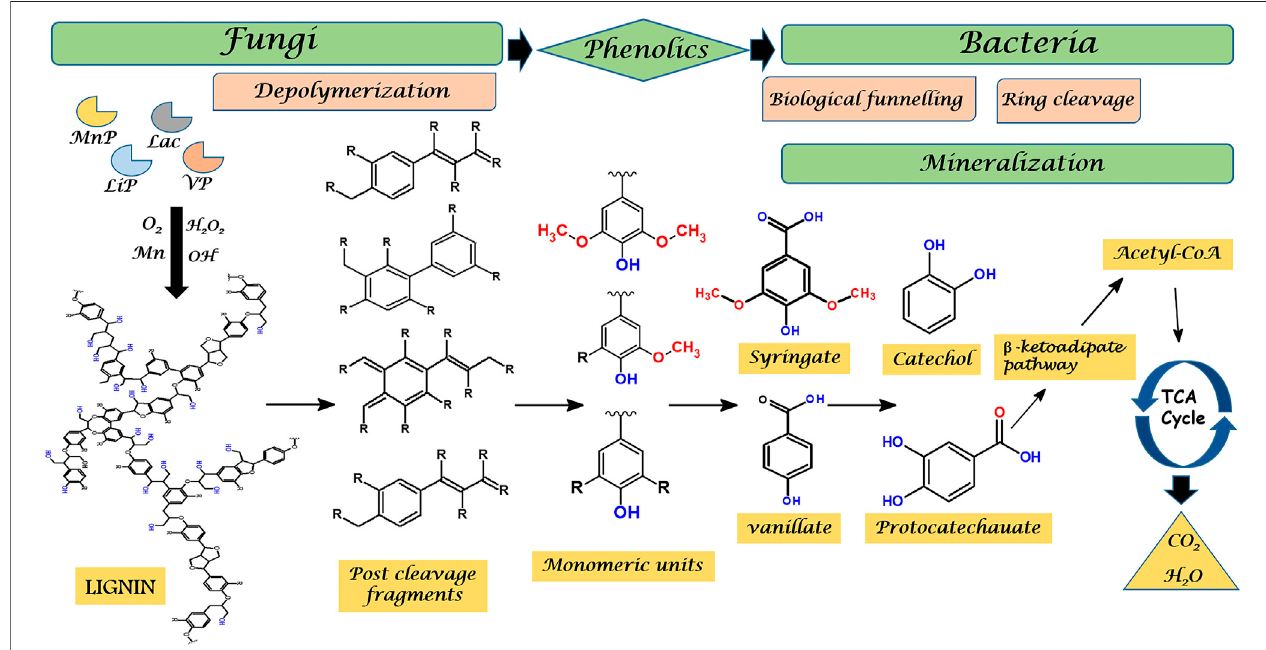
FIGURE 4 | Pathways involving the role of fungi and bacteria in enzymatic degradation of recalcitrant lignin. Where Lac, Laccase; LiP, Lignin peroxidase; MnP, Manganese peroxidase; VP, Versatile peroxidase; TCA, Tricarboxylic acid.